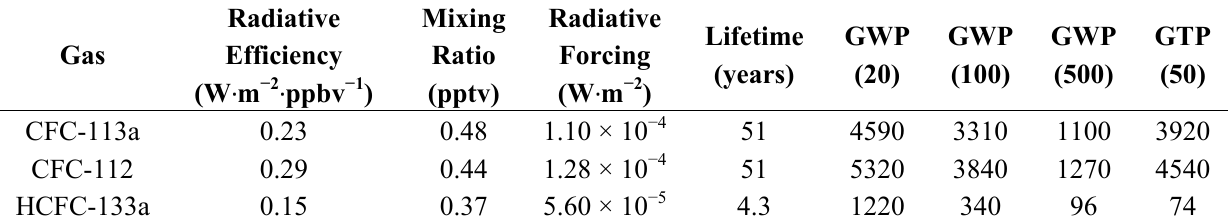
Table 1. Radiative efficiencies, mixing ratios in late-2012, present-day radiative forcings, atmospheric lifetimes, GWPs (for time horizons of 20, 100 and 500 years) and the GTP for a time horizon of 50 years, for the 3 gases considered